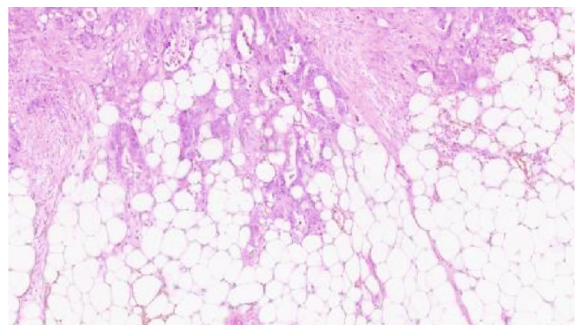
Figure 4: Focal conventional adenocarcinoma in fi ltrating perivesical fat.